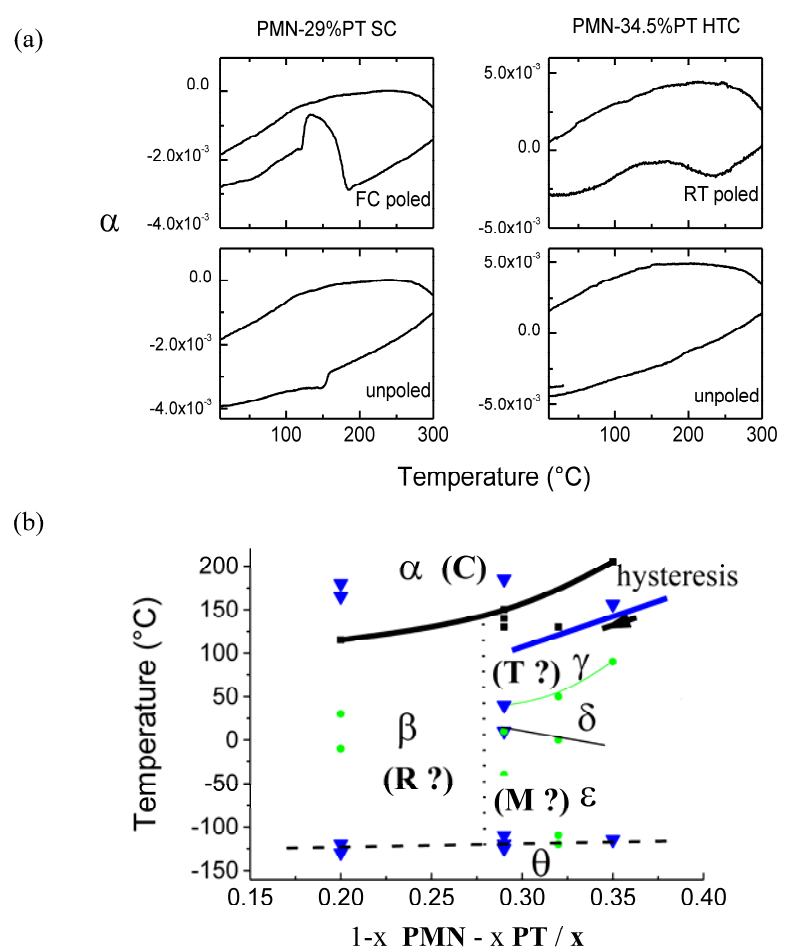
Figure 4. ( a ) Thermal expansion curves for poled and unpoled PMN-29%PT single crystal and PMN-34.5%PT textured ceramic; ( b ) PMN-PT phase diagram determined due to the thermal expansion results [61]. The symbols  –  mark the phases of different symmetry, which complete these ones determined by X-ray diffraction (cubic C, rhombohedral R, tetragonal T and monoclinic M). Note that the presence of the temperature hysteresis allows classification of some of these transitions as first order ones. The arrows mark the transition line on a cooling